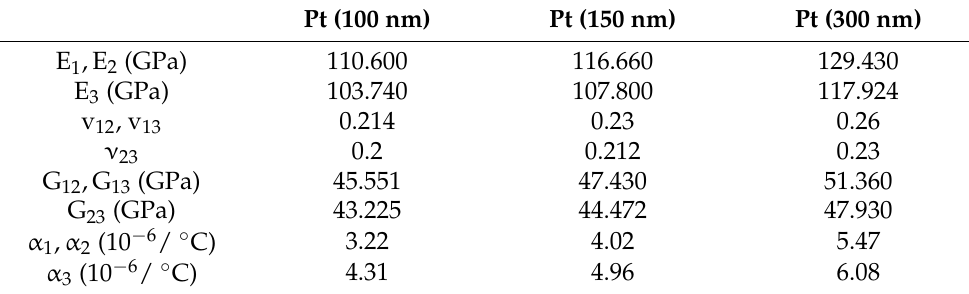
Table 2. Equivalent material